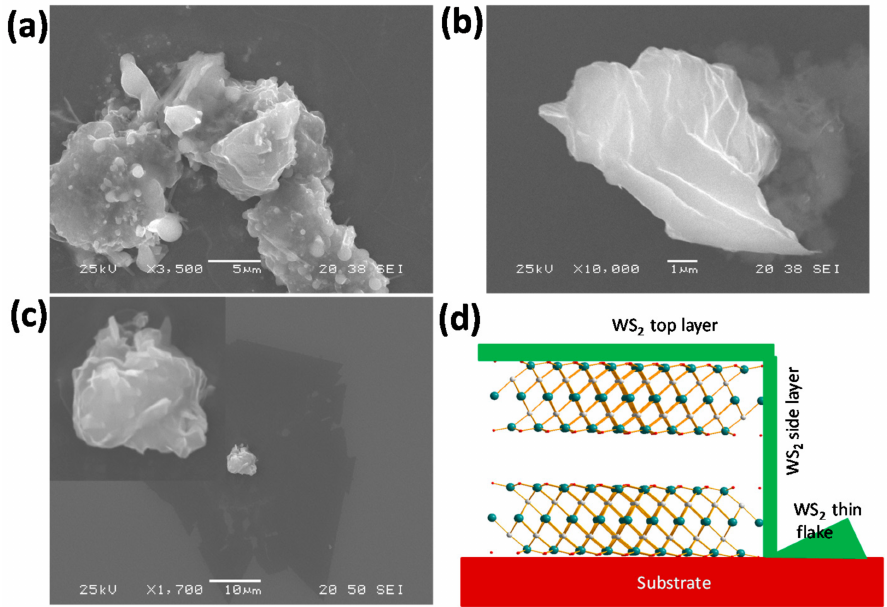
Figure 2. Morphology of WS 2 flakes growing on different Ti 3 C 2 T x flakes ( a – c ); ( d ) Schematic of possible growth mechanism of WS 2 on Ti 3 C 2 T x flakes. The inset of Figure 2c shows the magnified SEM image of WS 2 petals on Ti 3 C 2 T x . Note the flakes in ( a – c ) are chosen from samples deposited at 350